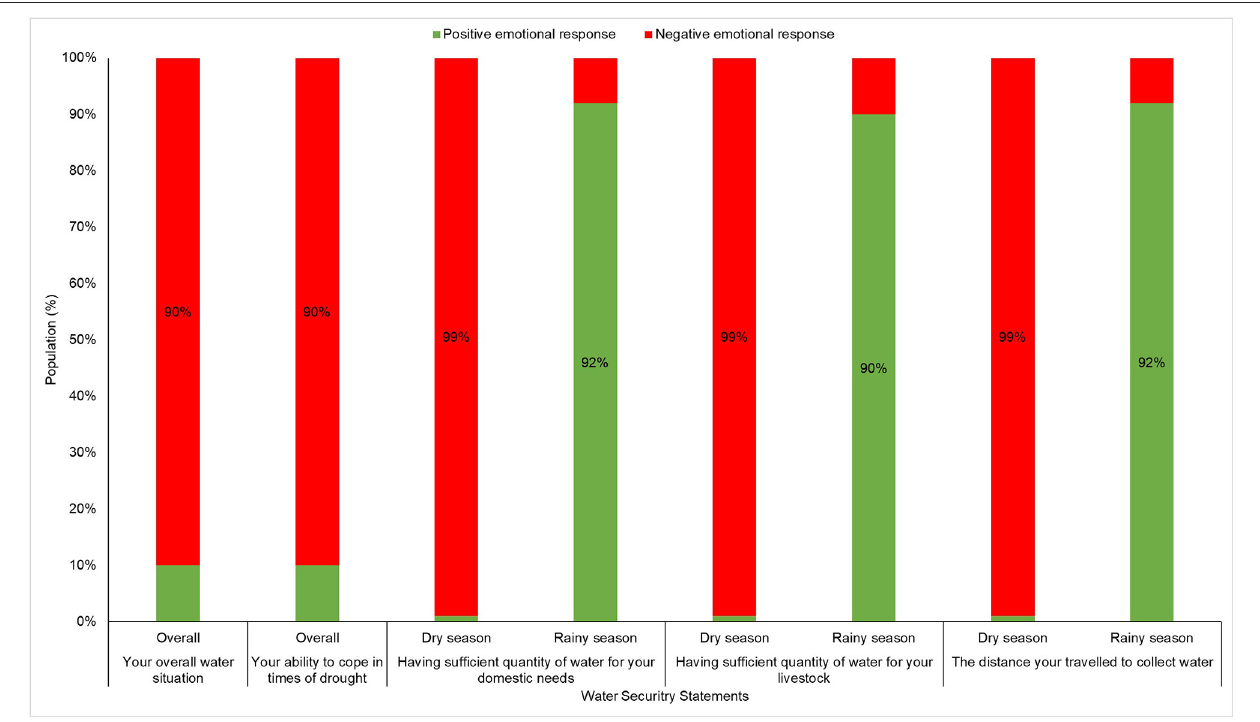
FIGURE 2 | Percentage of sample reporting positive or negative emotions to water security statements.